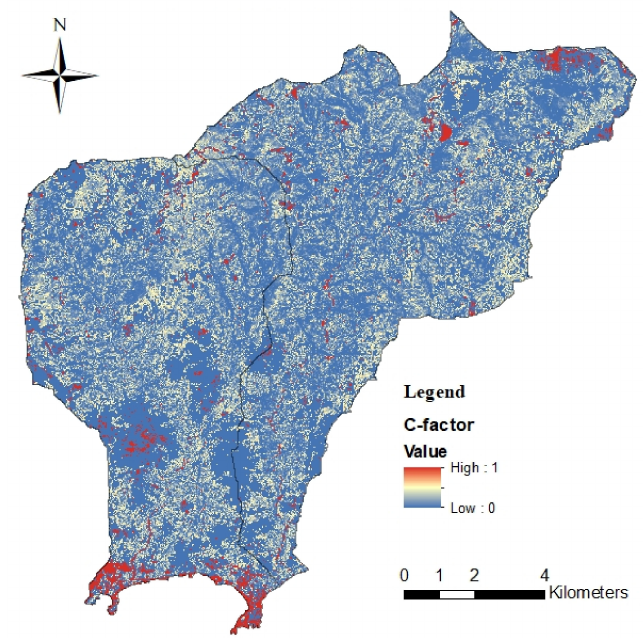
Figure 11. C(vk)-factor map.